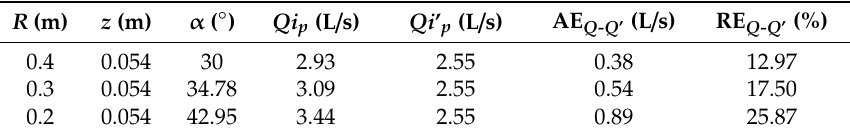
Table 11. Comparison using the Absolute Error and the Relative Error of the flow rate for the initiation of the jet flow, obtained by the proposed methodology and formula and considering whether or not the radius-dependent term, respectively Qi p and Qi ’ p , for z = 0.054